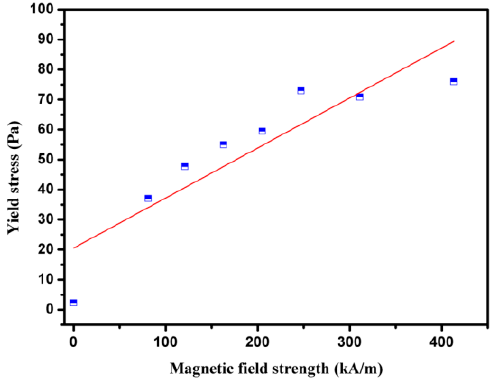
Figure 7. The yield stress of the amorphous MF as a function of magnetic field.